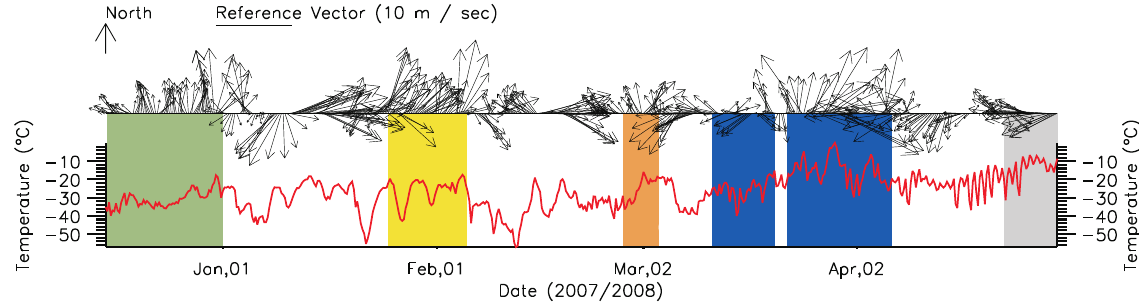
Fig. 2. Atmospheric data (NCEP/DOE, 6-hourly) for the 2007/2008 winter study period. Vectors along top of diagram show wind velocities (speeds and directions) of air flow (north-directed reference vector has 10ms − 1 speed), and main diagram depicts air temperatures 2m above the ice surface. Each value represents a single point nominally in the center of the area of interest. Colored frames identify four polynya opening events. The fifth polynya event occurred after the HEM survey and is not considered in this